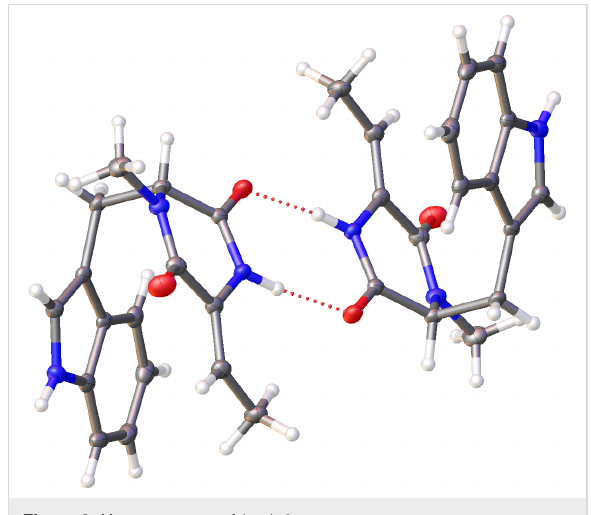
Figure 2: X-ray structure of ( rac )- 4 .